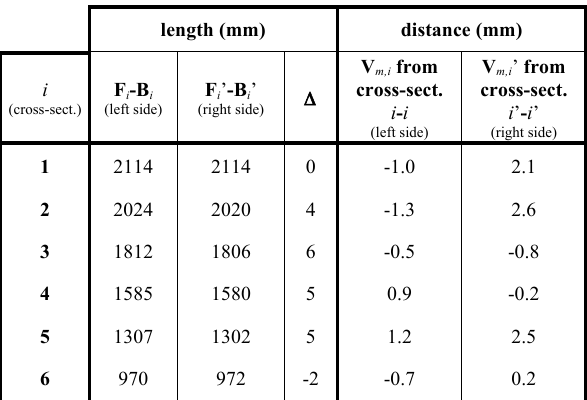
Tab. 2: Length and planarity of cross-sections